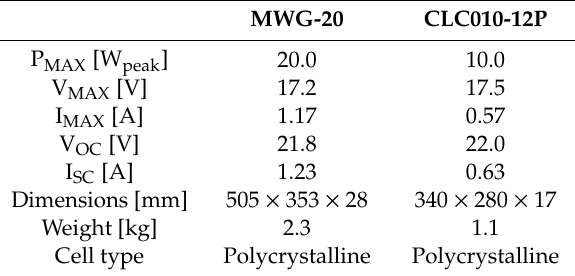
Table 4. Datasheet of PV module MWG-20 and CLC010-12P.